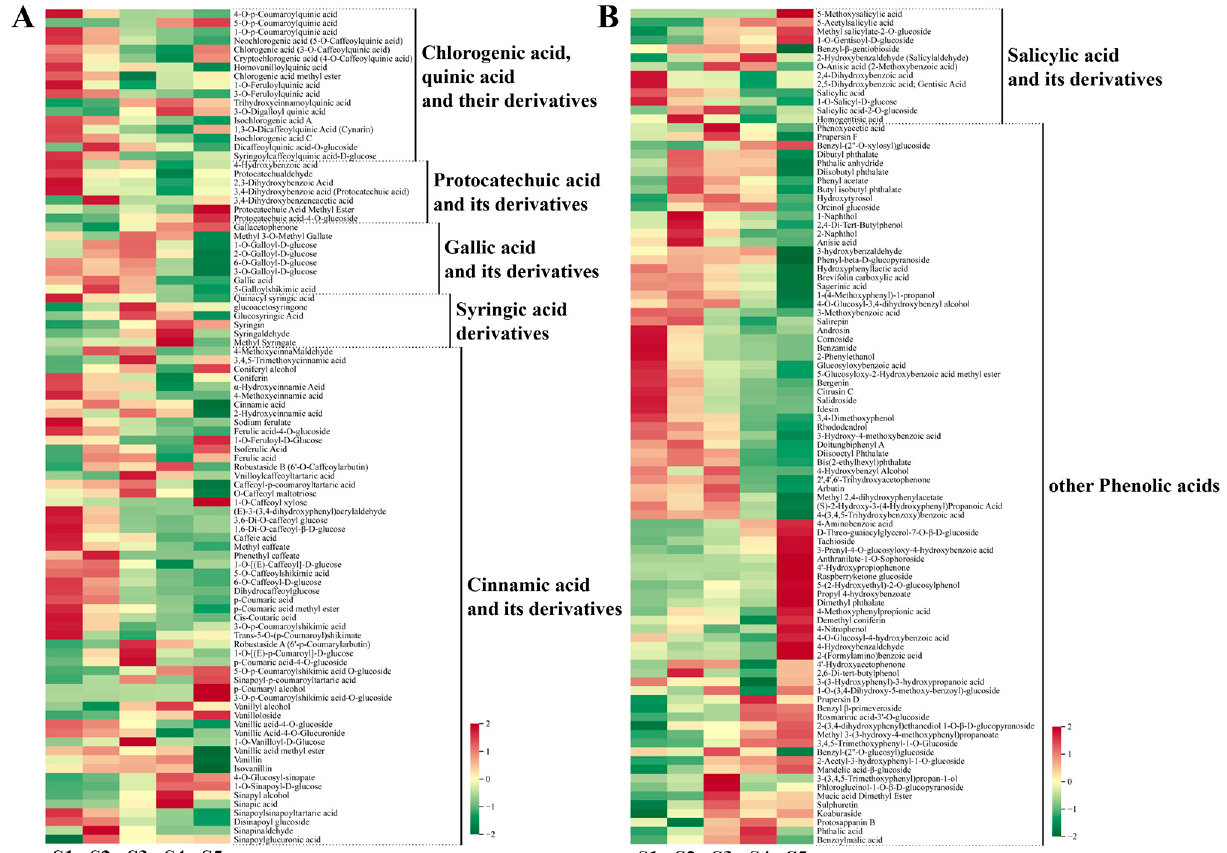
Figure 5. Cumulative distributions of phenolic acid compounds detected through broadly targeted UPLC-MC/MS at the five fruit developmental stages. ( A ) Metabolic heat map of chlorogenic/quinic acid and its derivatives, protocatechuic acid and its derivatives, gallic acid and its derivatives, syringic acid derivatives, and cinnamic acid and its derivatives; ( B ) metabolic heat map of salicylic acid and its derivatives, along with other phenolic